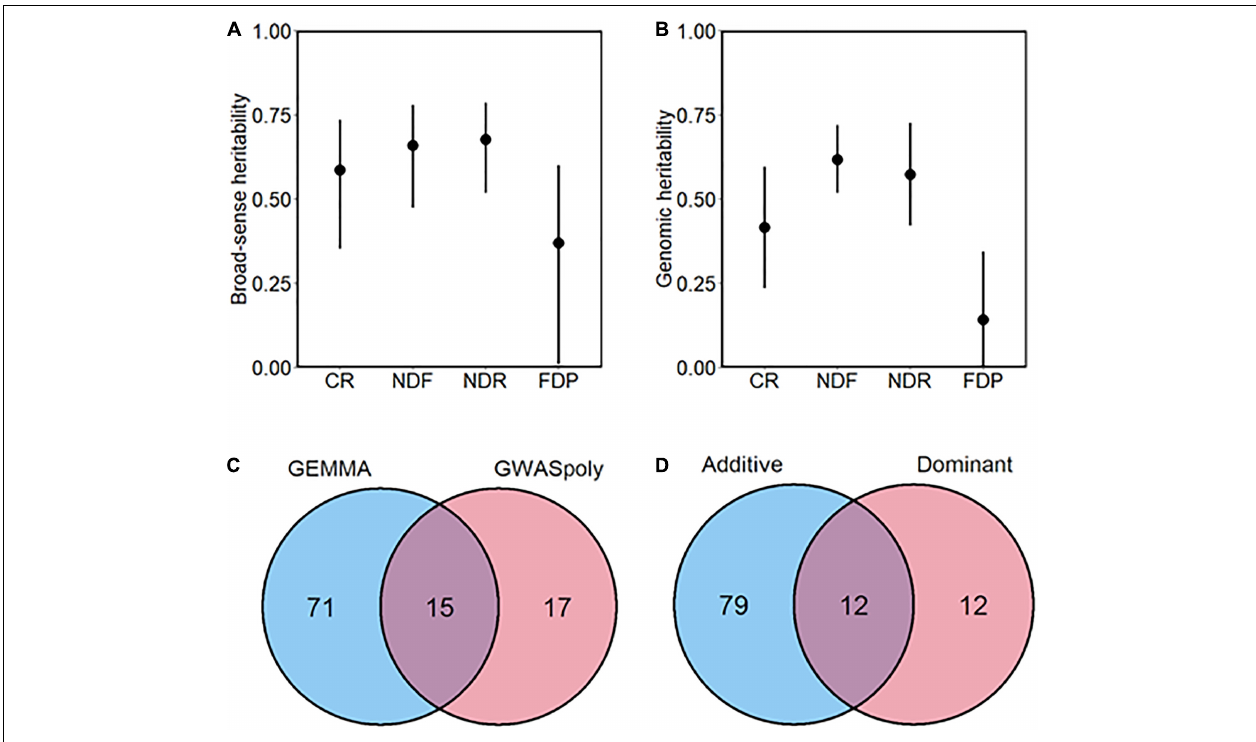
FIGURE 3 | Overview of the genome-wide association study (GWAS) analysis conducted in this study. (A) Broad-sense and (B) genomic heritability of each phenology-related trait. Bars represent 90% CI. (C) The total number of significant phenotype-genotype associations detected by two GWAS methods. (D) The total number of significant phenotype-genotype associations detected by two gene action models.